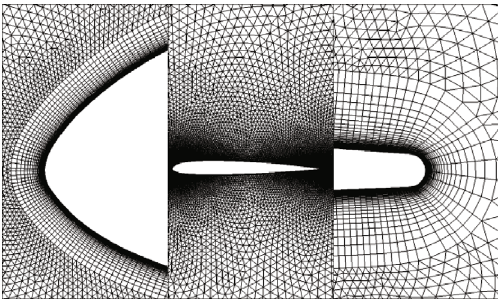
Figure 7: Mesh around the airfoil.